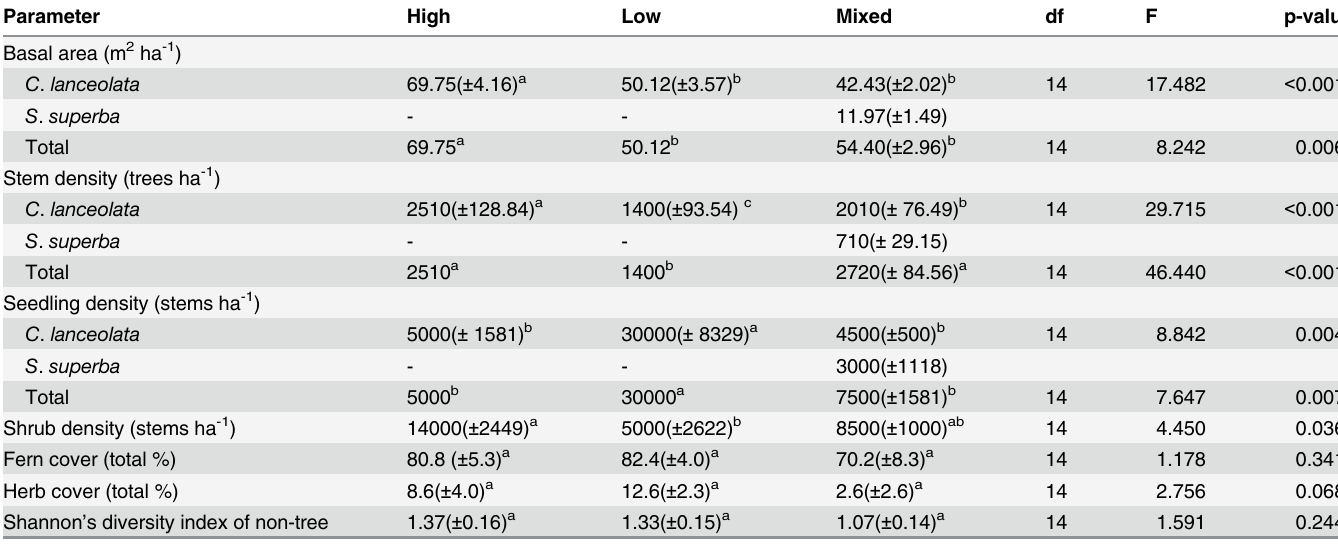
Table 2. Structural traits (means ± SE) of the stands (n = 5 plots per stand) at Datian. Parameter High